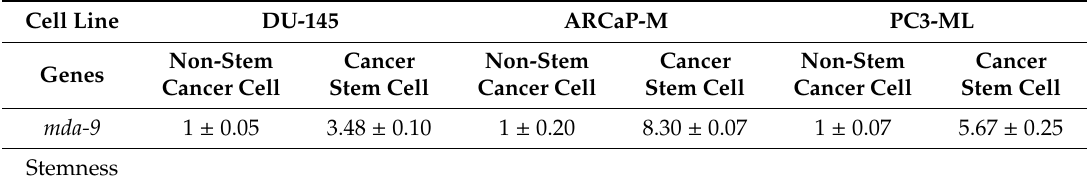
Table 1. Expression of mda-9 and stemness genes in non-stem prostate cancer cells and prostate cancer stem